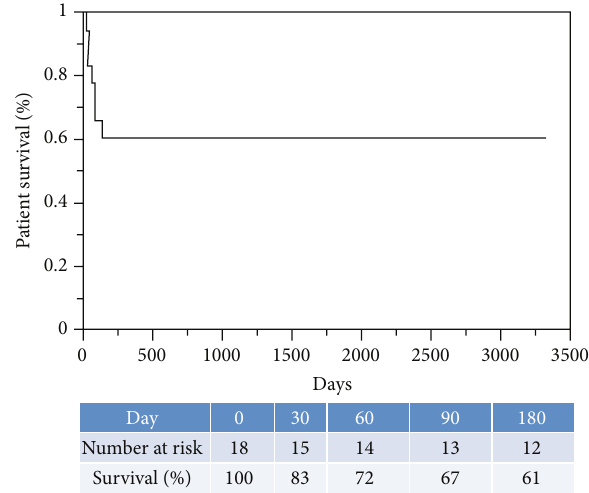
Figure 1: Patient survival